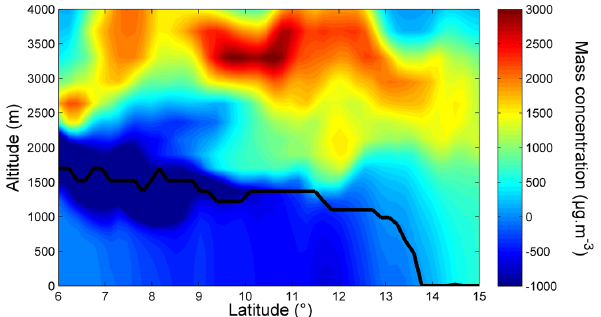
Fig. 12. Difference of dust mass concentration between the simula- tion without sedimentation (NOSED) and the simulation including sedimentation (SED; see text for more details) at 12:00UTC on 13 June. Negative mass concentrations correspond to sedimented par- ticles. The black line illustrates the top of the monsoon flux.